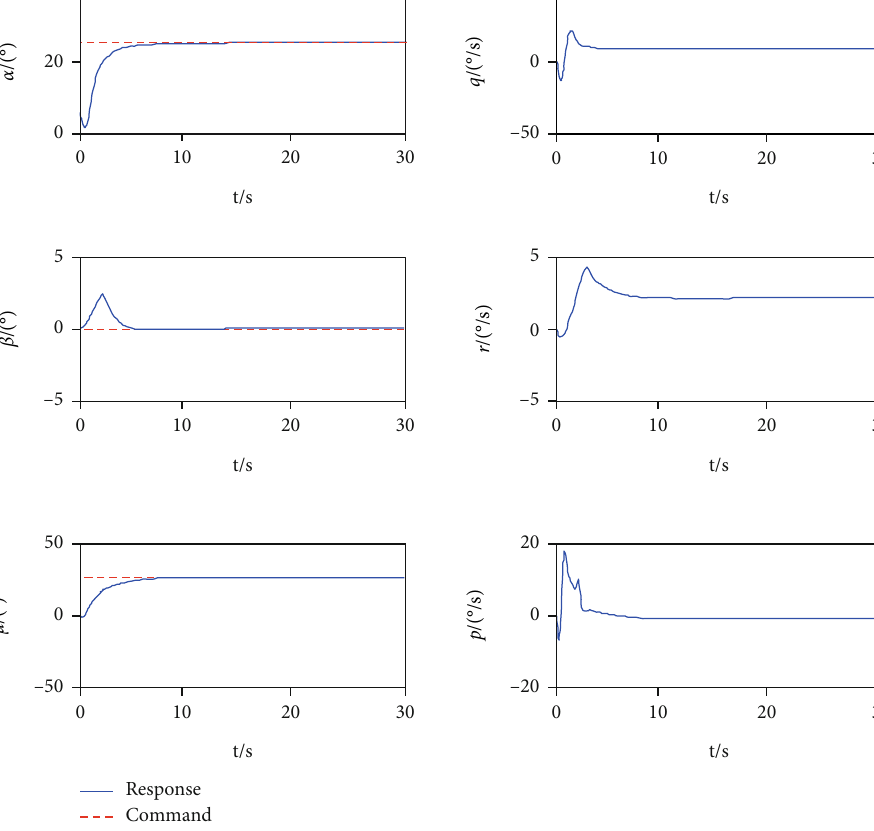
Figure 7: The state response of three-axis maneuver against fault mode